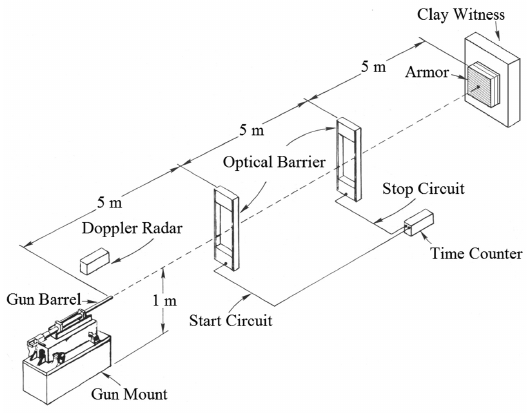
Figure 4. Schematic exploded view of the ballistic experimental